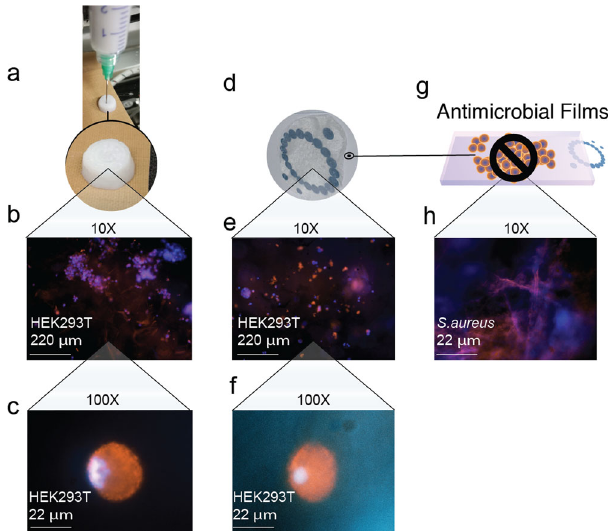
Fig. 5 Cell culture on EnCNCh. a Image of LFACA-EnCNCh cylindric scaffold 3D printing, where HEK293T cells wereseeded. b Confocal microscopy image at10X and ( c ) 100XofHEK293T-stainednucleiwith DAPI and cell membrane with Orange Plasma. Cells proliferated embedded on EnCNCh matrix after 3 days of culture. d Picture of EnCNCh fi lm where HEK293T cells were grown. e Confocal microscopy image at 10X and (f) 100X of HEK293T stained with DAPI and Orange Plasma seeded and grown on the fi lm. g Representation of EnCNCh fi lm where S. aureus bacteria do not grow after 24h of incubation. h Confocal images of EnCNCh fi lm after incubating S . aureus